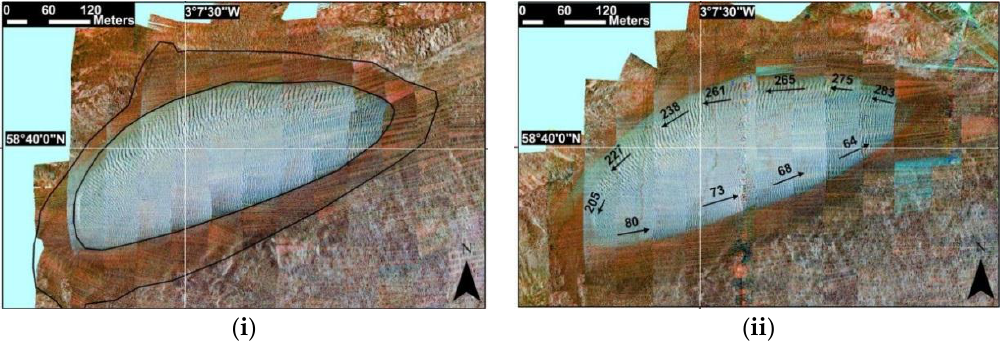
Figure 4. Dune crest directions on the oval shaped sand bank during spring flood tide, June 2015 ( i ) and ebb tide, May 2015 ( ii ). Little change in dune shape was detected. Arrows indicate crest direction for ebb tide (in geographic degrees). Overlain in ( ii ) black line shows dune outline position and position of halo surrounding dune from June survey in ( i ).